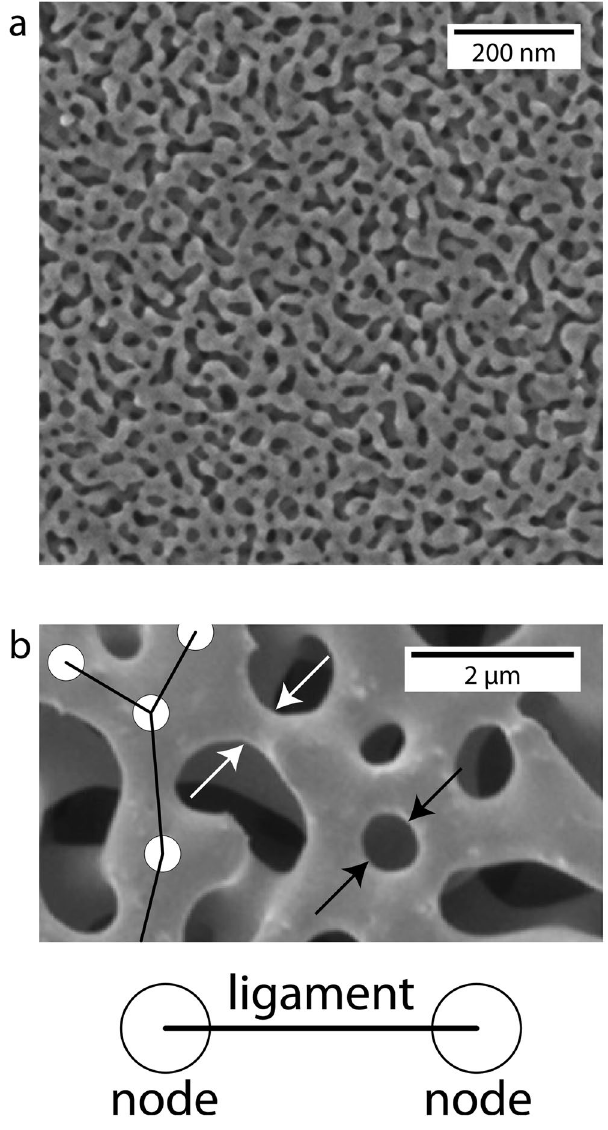
Figure 1. Nanoporous gold (NPG) and its physical characteristics. ( a ) Representative electron micrograph of NPG reprinted with permission from ref. 7 . ( b ) Higher magnification electron micrograph reprinted with permission from ref. 8 illustrating some physical characteristics of NPG: nodes (shown as circles), ligaments (shown as lines), ligament diameter (white arrows), and pore diameter (black